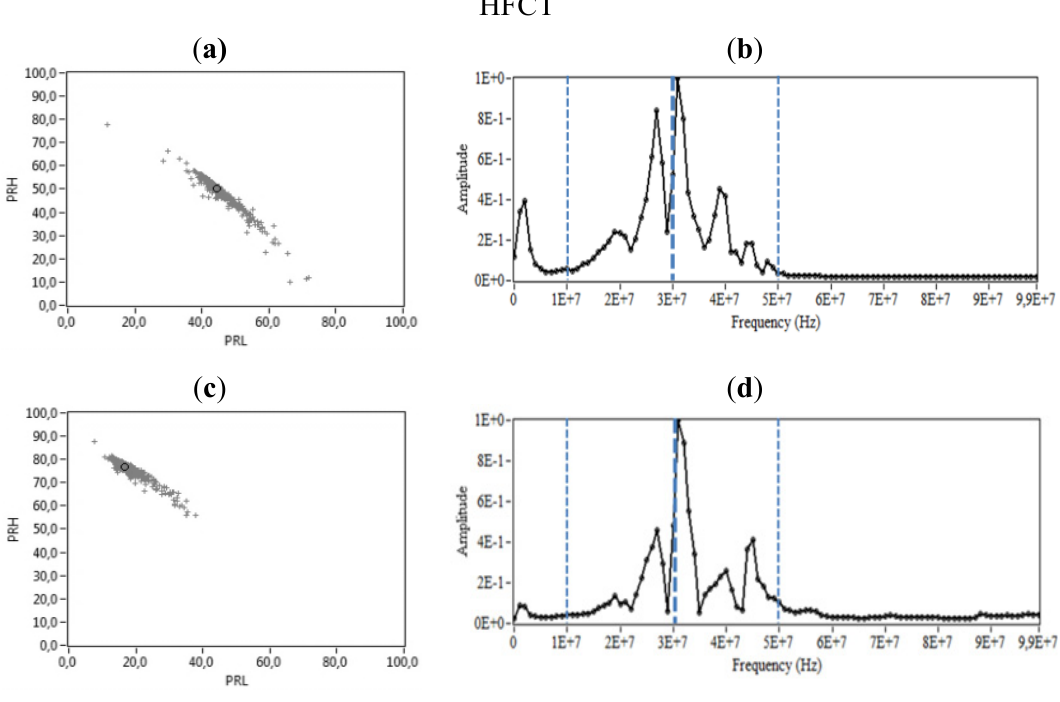
Figure 12. Internal PD. ( a ) PR map of the signals measured with the HFCT, ( b ) Normalized average spectral power of the signals measured with the HFCT, ( c ) PR map of the signals measured with the ILS, ( d ) Normalized average spectral power from the signals measured with the